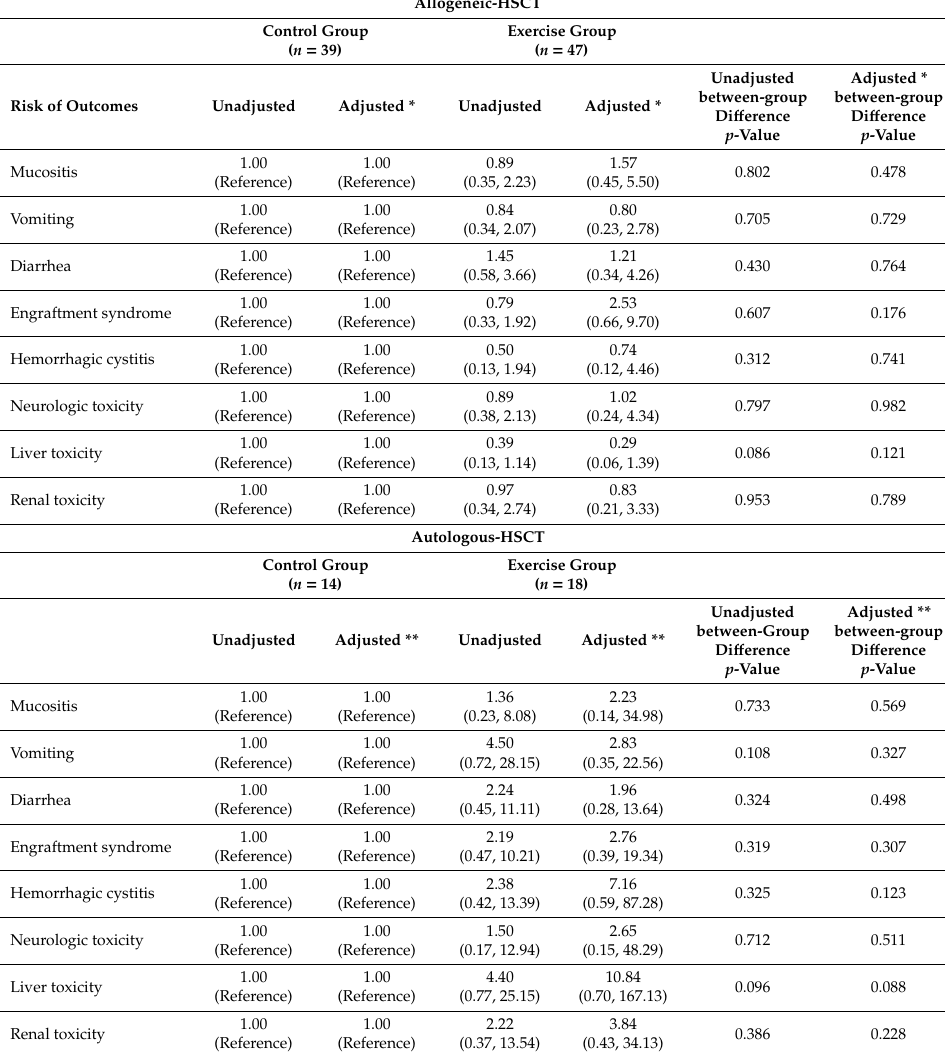
Table 5. E ff ects of exercise intervention on secondary outcomes (toxicity profile, any